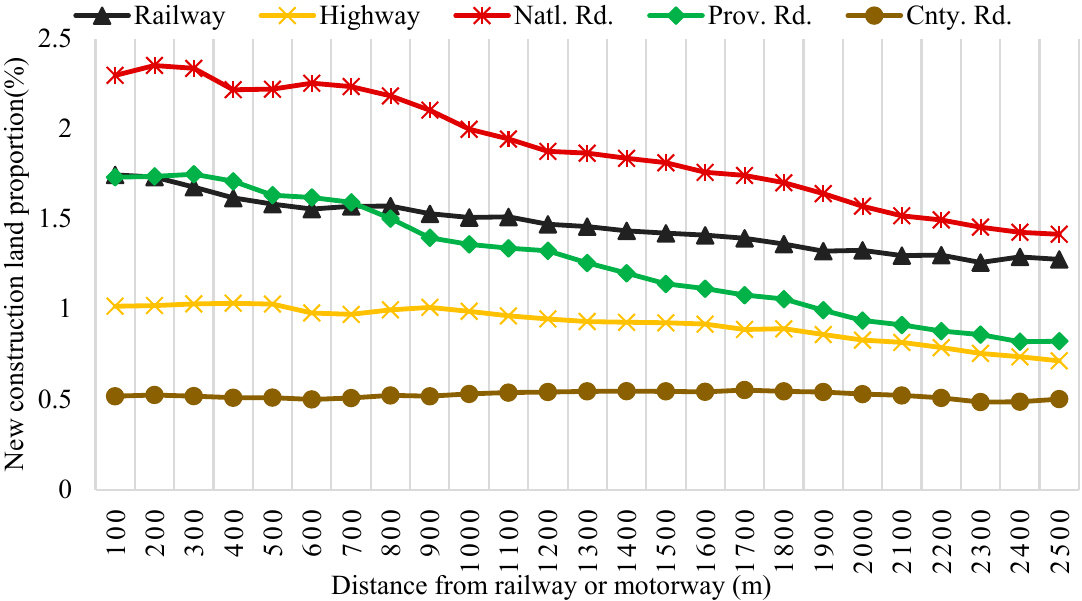
Figure 6. The sprawl of construction land on the road side of railways and motorways from 1995 to 2015.